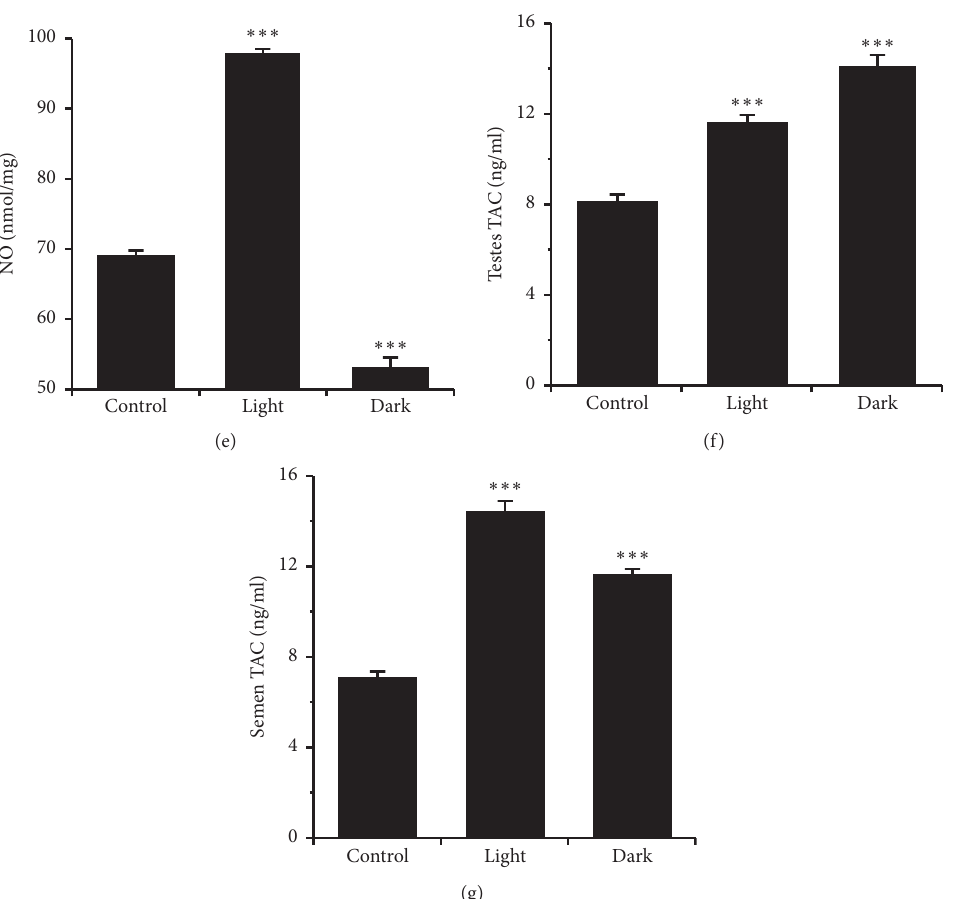
Figure 3: Changes in the levels of antioxidant enzymes, MDA, NO, and TAC. Testicular levels of (a) CAT (ng/mg), (b) SOD (U/mg), (c) GPx (ng/mg), (d) MDA (nmol/mg), (e) NO (nmol/mg), (f) TAC, and (g) semen TAC levels (ng/ml) in male rats following exposure to prolonged light or prolonged darkness for 12 consecutive weeks. Data are presented as means ± SEM ( n � 8–10 rats). ∗∗∗ P ≤ 0 . 001 vs the control group by Student’s t